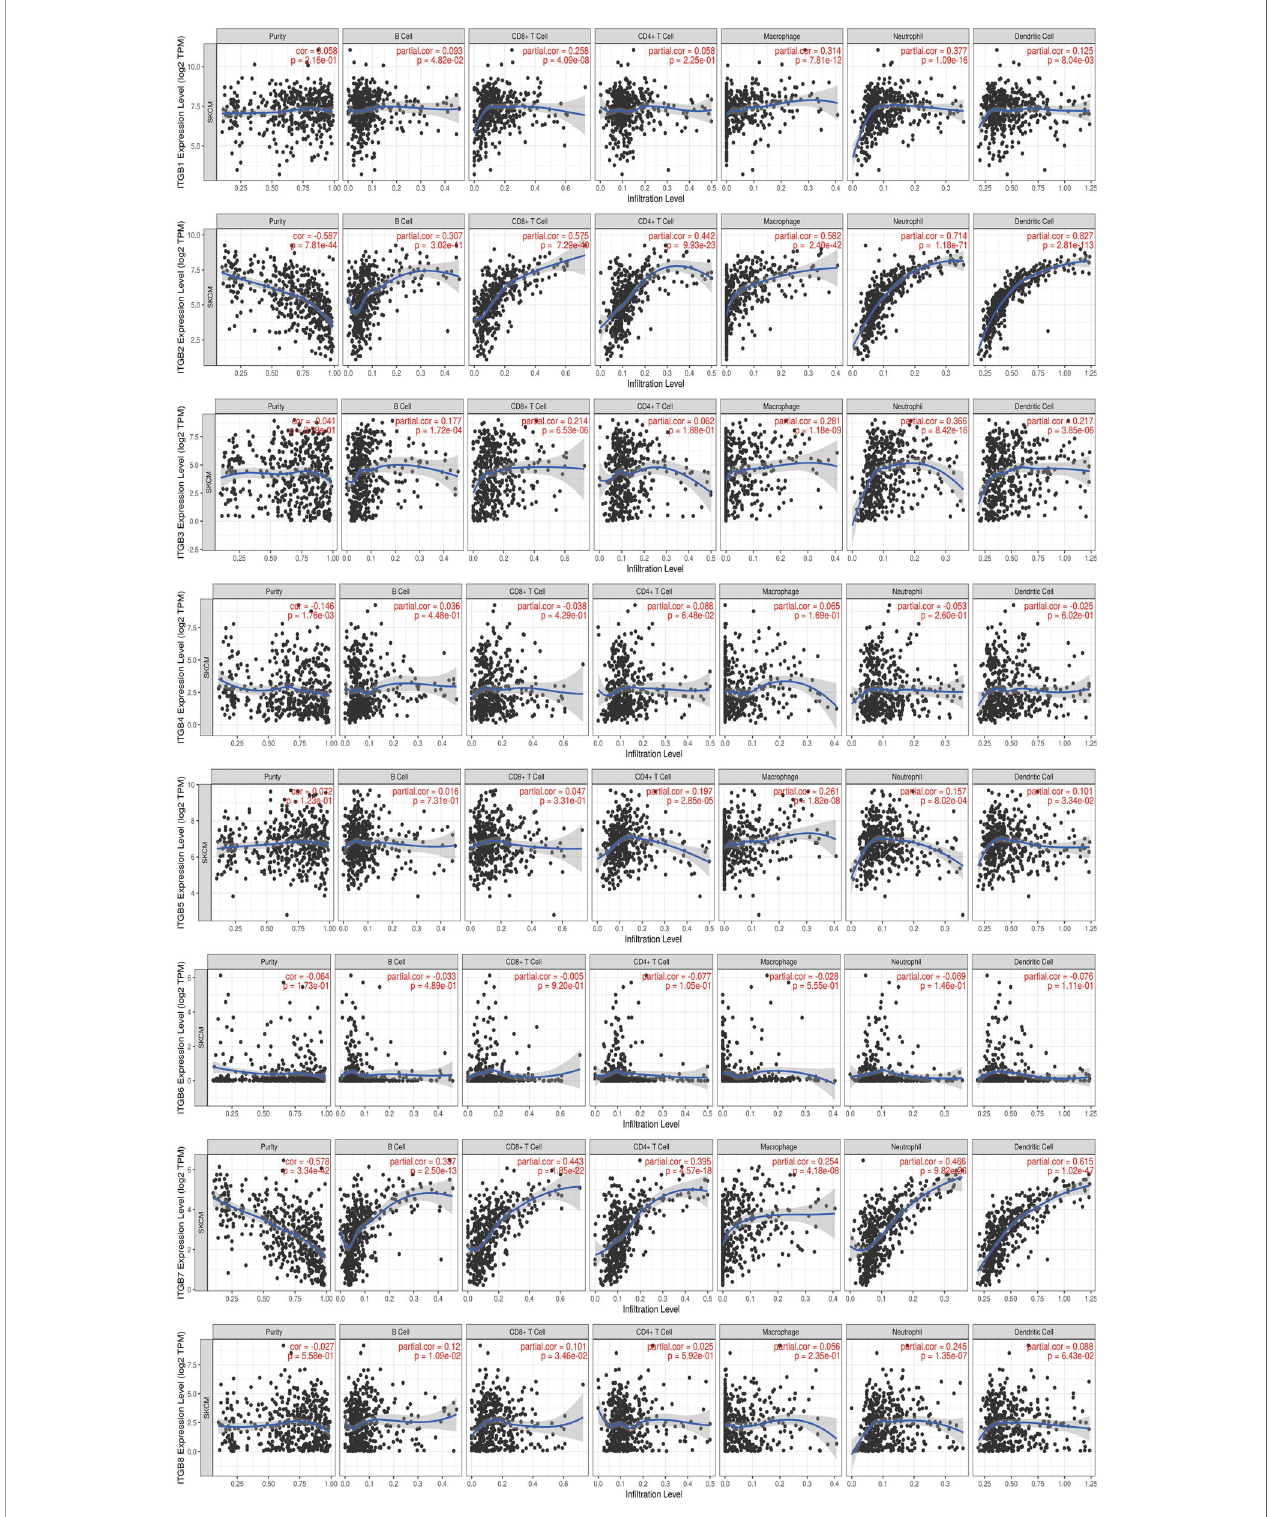
FIGURE 8 | Immune in fi ltration associated with ITGB1 – ITGB8 in SKCM patients (TIMER). Spearman correlation coef fi cient was used for statistical analysis. A P value less than 0.05 was used to determine statistical difference.